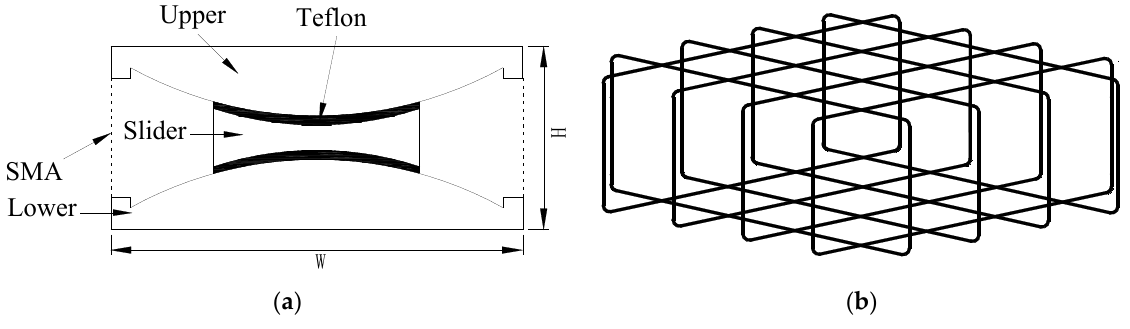
Figure 3. ( a ) Profile, ( b ) SMA cable layout.